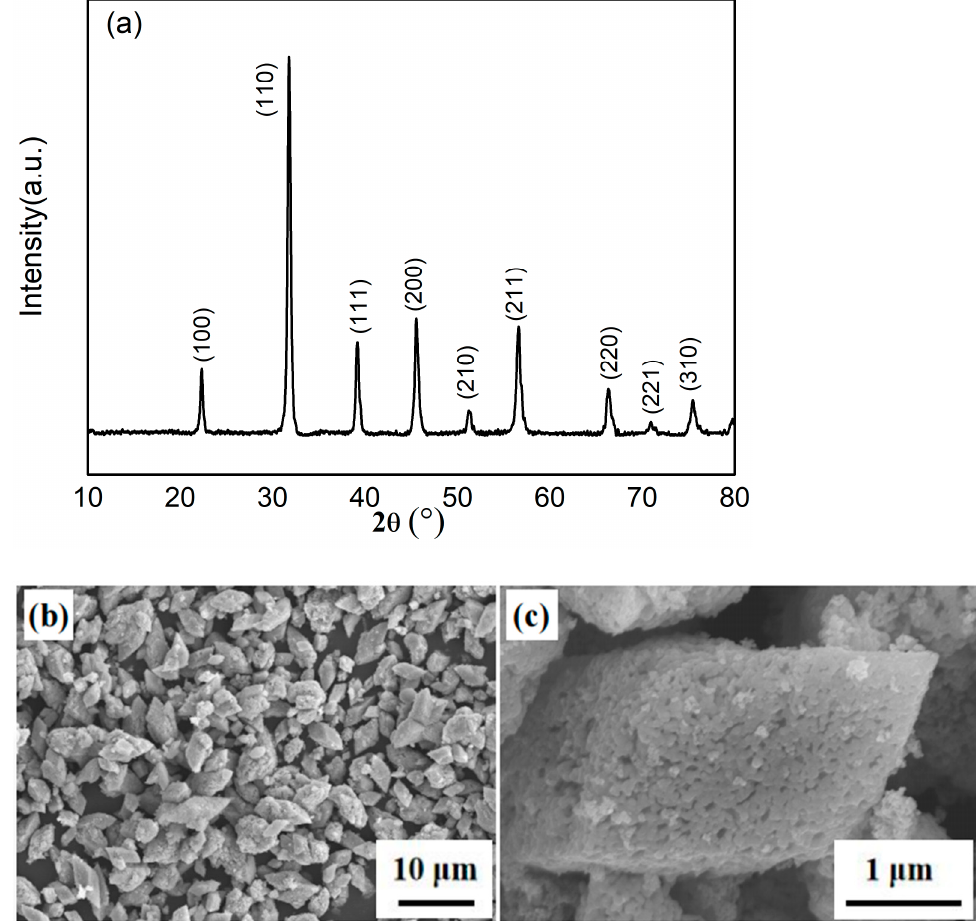
Figure 3. ( a ) The XRD spectrum, ( b ) SEM, and ( c ) partial enlarged SEM image of BST precursors calcined at 800 °C for 2 h.